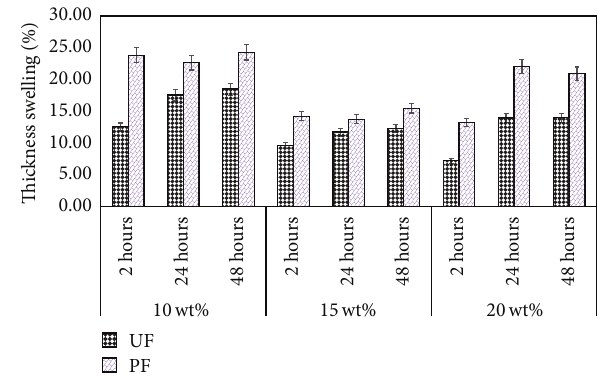
Figure 8: Thickness swelling of sago particleboard versus resin matrix content